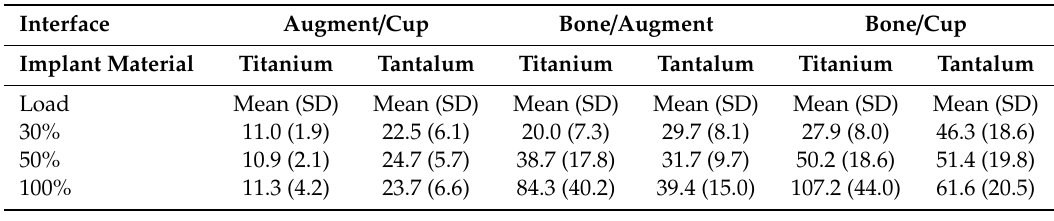
Table 1. Table showing the mean and standard deviation (SD) of the relative motion ( μ m) of tantalum (Trabecular Metal) and titanium (Gription) implants at the respective implant/bone interfaces and load levels.